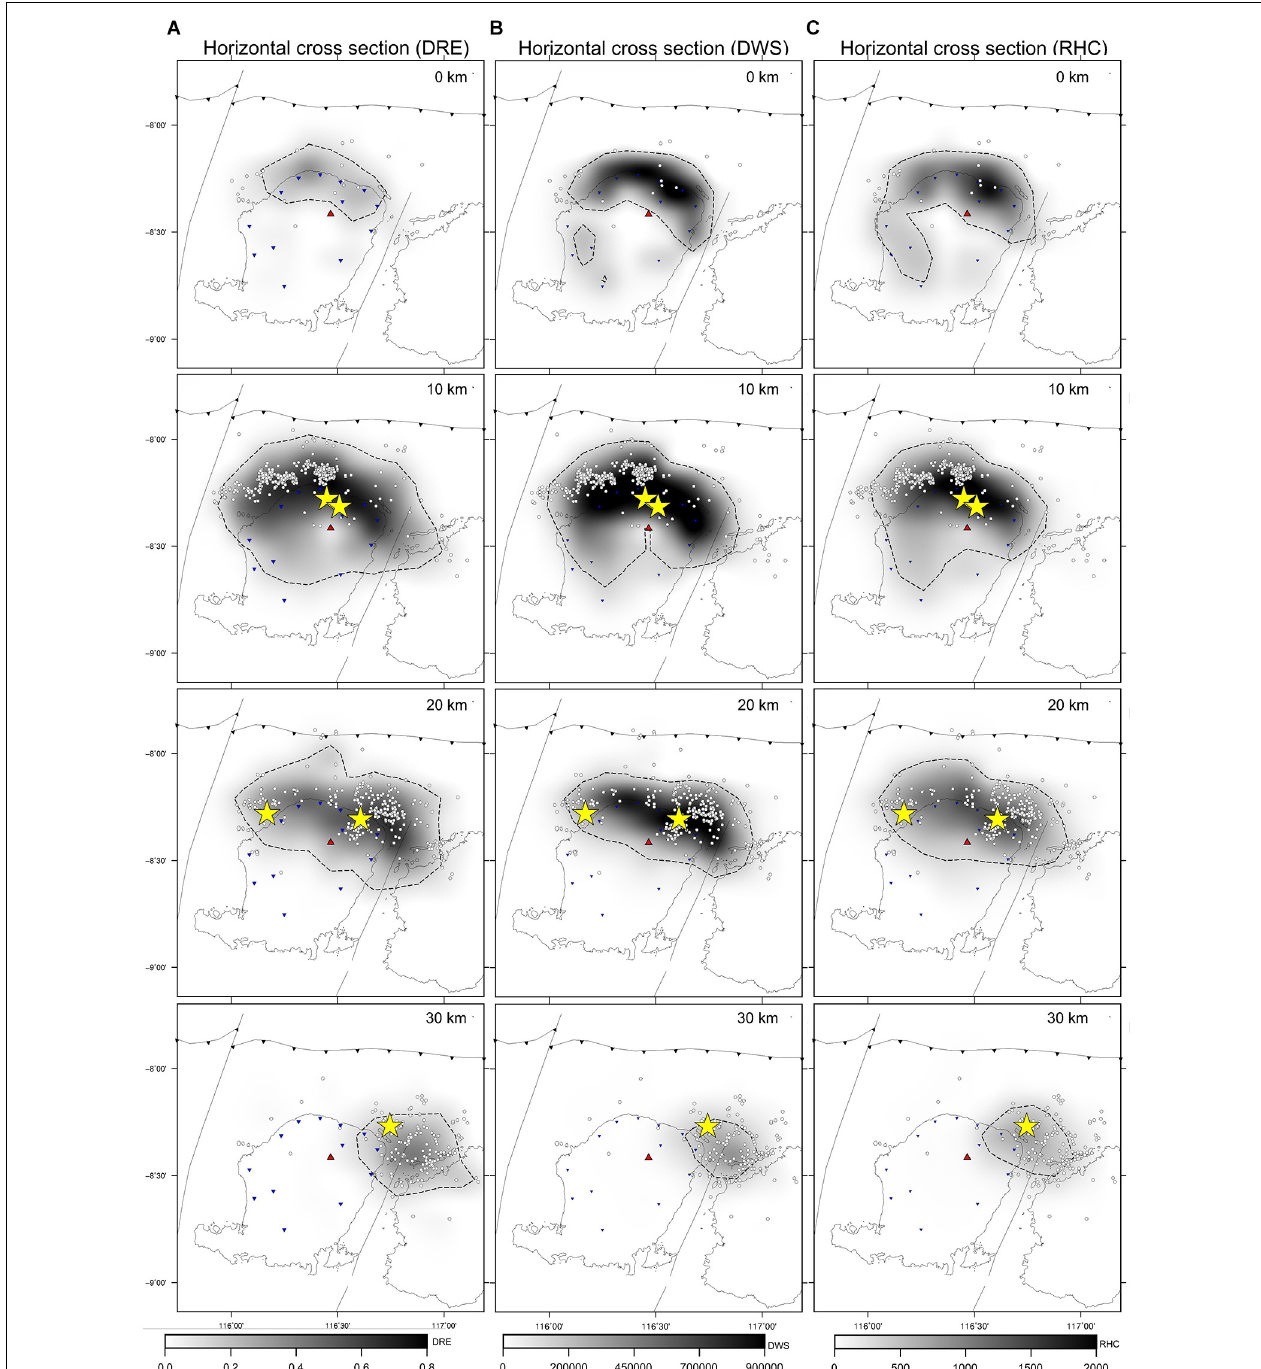
FIGURE 5 | Horizontal slice at 0, 10, 20, and 30 km depth for (A) Diagonal Resolution Element (DRE), (B) Derivative Weight Sum (DWS), and (C) Ray Hit Count (RHC) of Q p . Black and white colors indicate high and low values; white circles are the